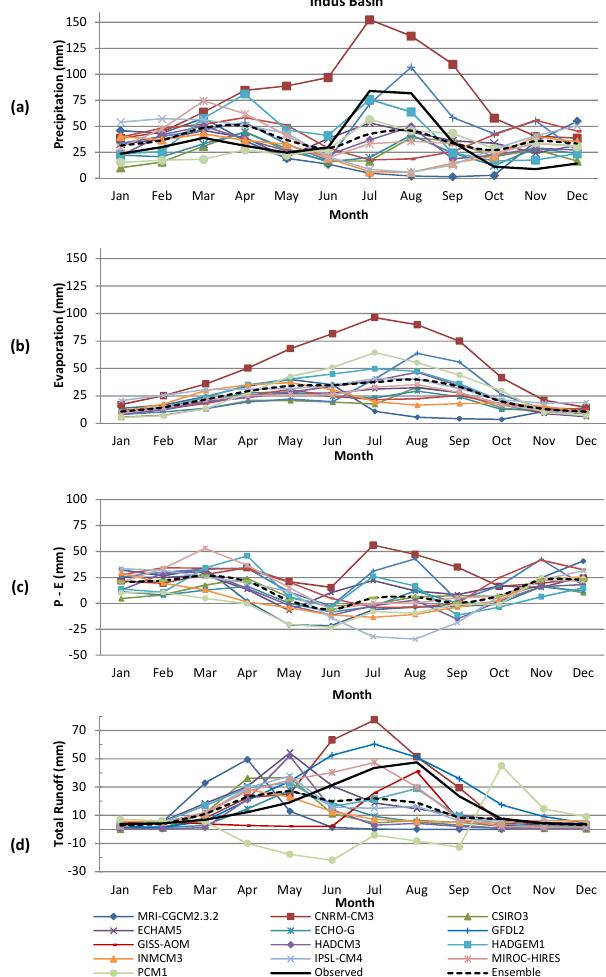
Fig. 2. 20th century annual cycles of considered quantities for the Indus Basin: (a) P , (b) E , (c) P − E , (d) R . Note that as the In- dus River is highly diverted for irrigation and other purposes, its estimated natural discharge (by adding diverted volume to actual discharge into sea) is